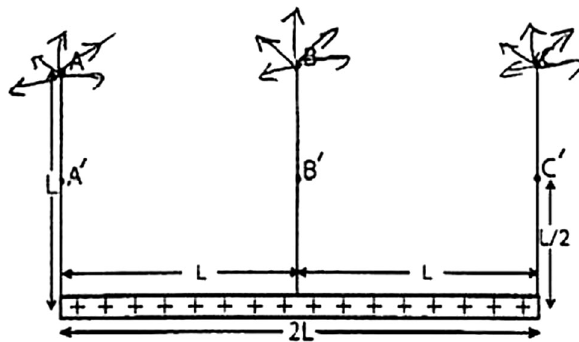
FIG. 3. A sample drawing from a student for pretest question (1) showing the direction of the electric field at points A , B , and C